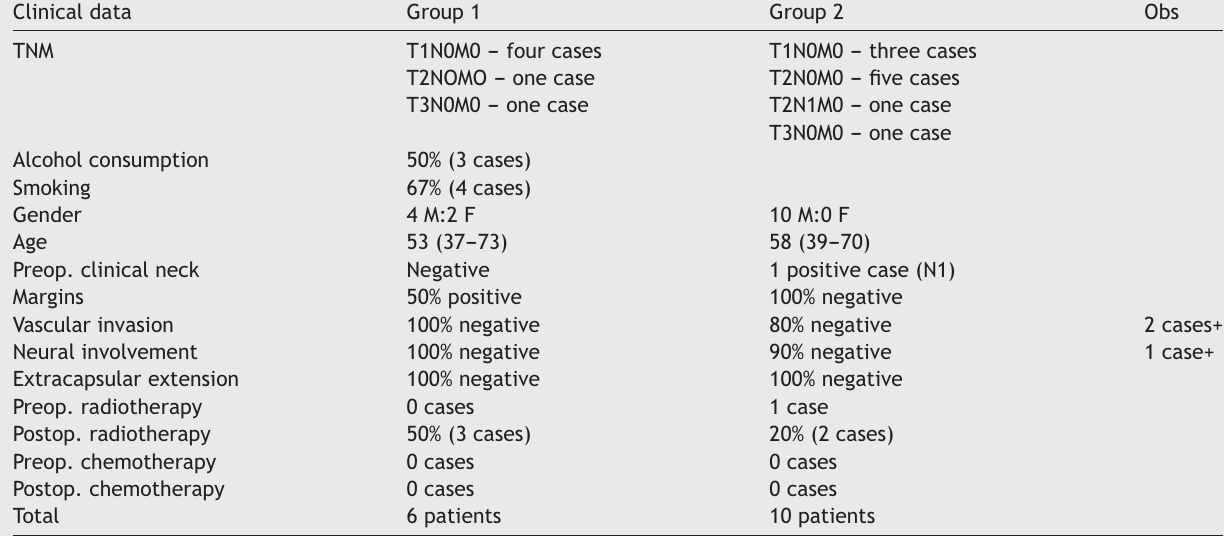
Clinical data of study patients.